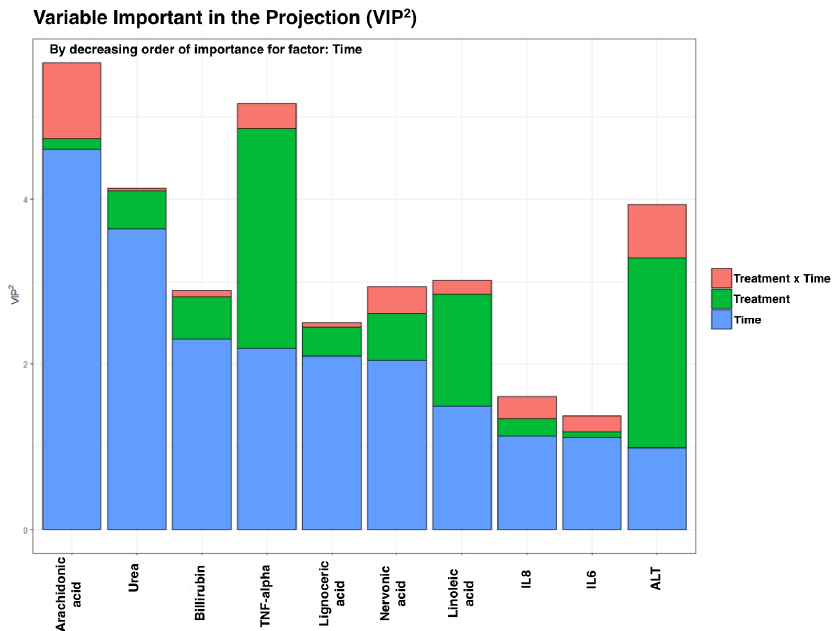
Figure 2. Most discriminant features according to the amOPLS approach for the integrated analysis of the general biochemistry, FAs, and inflammatory biomarkers in plasma. The variables are ordered by the VIP 2 value corresponding to the time effect. VIP 2 : variable of importance in the projection. The higher it is, the more influence on the model .